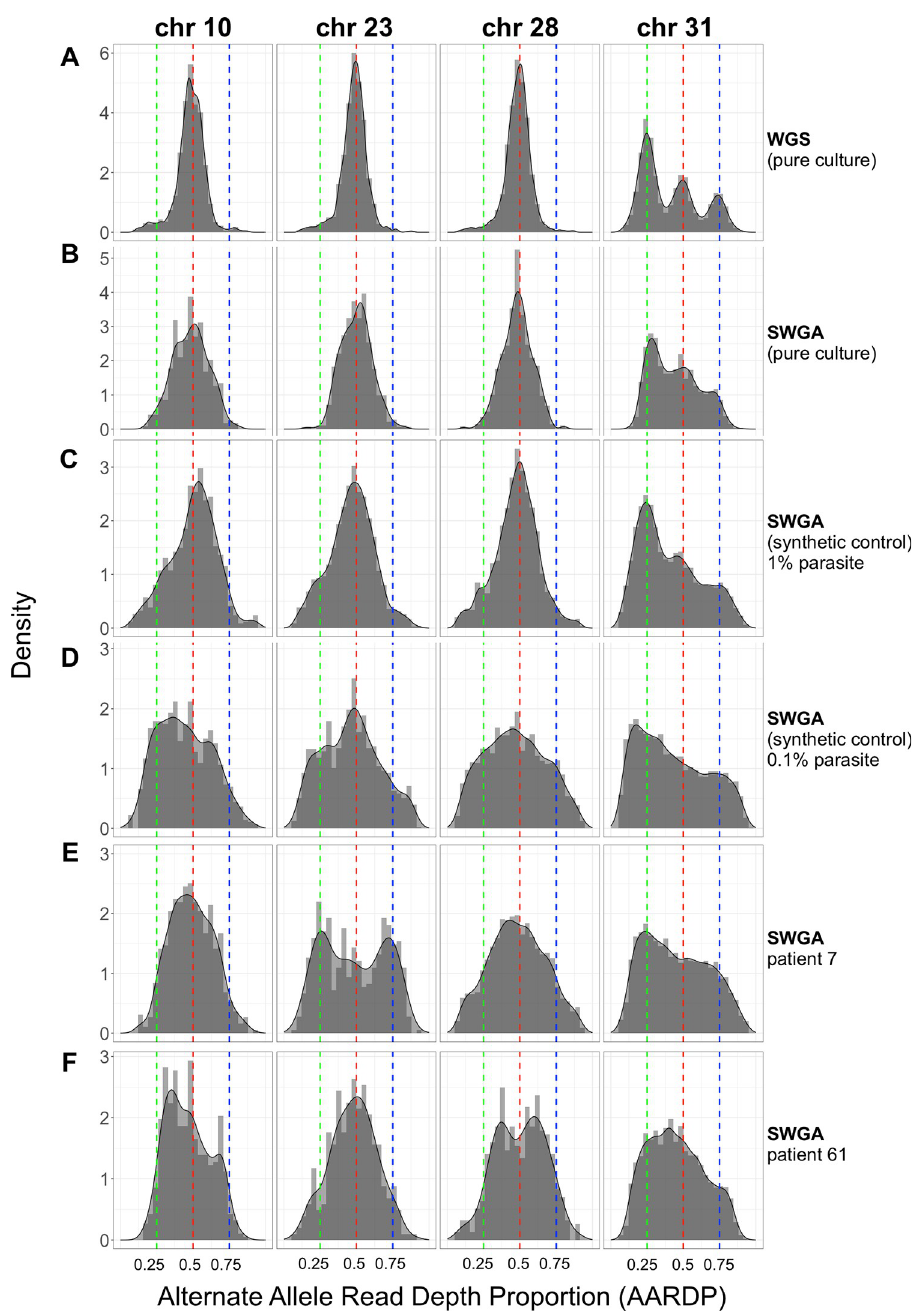
Fig 3. Allele frequency determined by SWGA. Alternate Allele Read Depth Proportion (AARDP) histograms for L . braziliensis chromosomes 10, 23, 28, and 31, for (A) whole genome sequencing (WGS) of pure cultured parasites, (B) SWGA of pure cultures, (C-D) SWGA of synthetic controls consisting of 1% (C) or 0.1% (D) parasite DNA, (E-F) SWGA on two patient samples from Fig 2B. Peaks centered on 0.5 indicate disomic chromosomes, while peaks at approximately 0.25, 0.5 and 0.75 indicate tetrasomic chromosomes. Green, red, and blue dashed lines denote an AARDP of 0.25, 0.5, and 0.75,